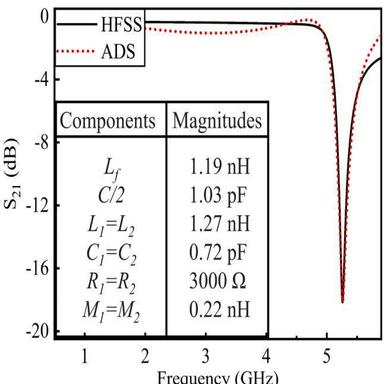
Comparison between EM simulation and Circuit simulation of the proposed sensor.